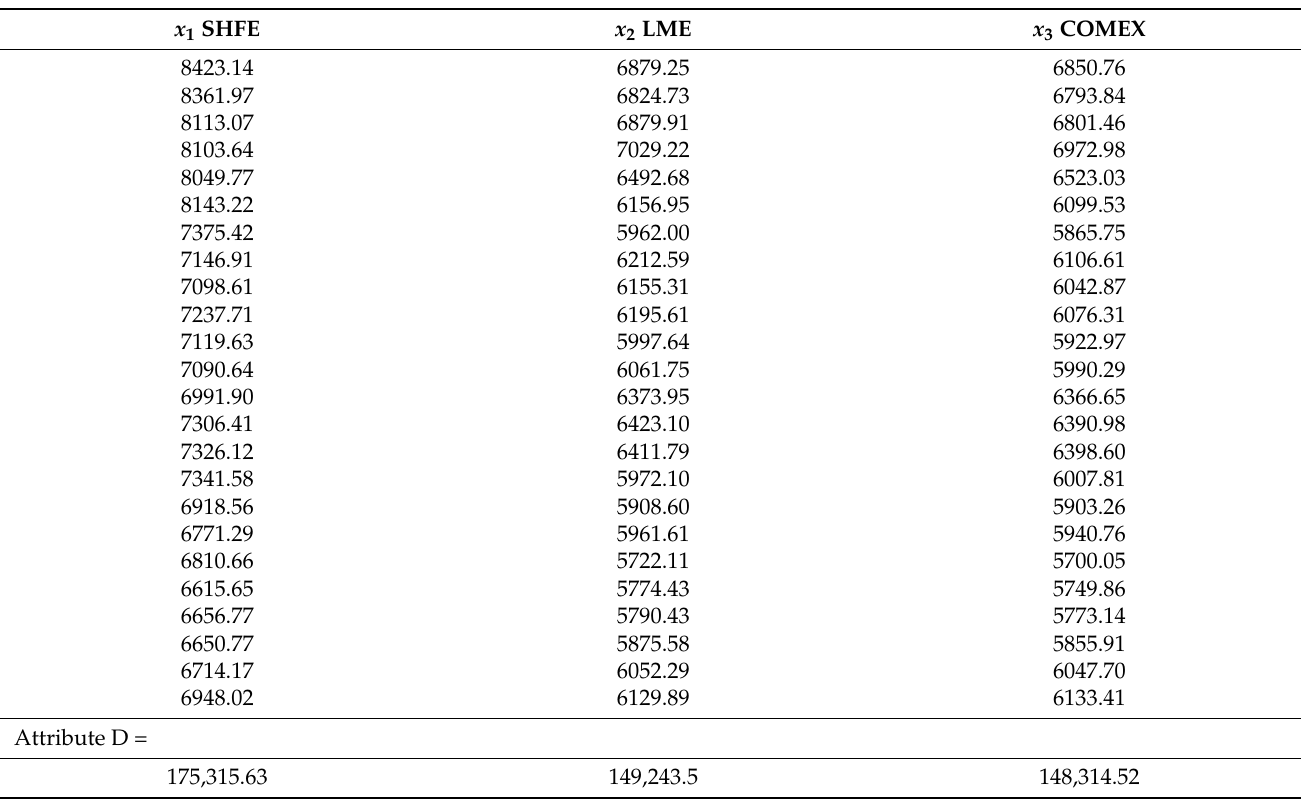
Table 1. Values of attribute “D” calculated using grey entropy and by importing data from three copper futures markets before the COVID-19